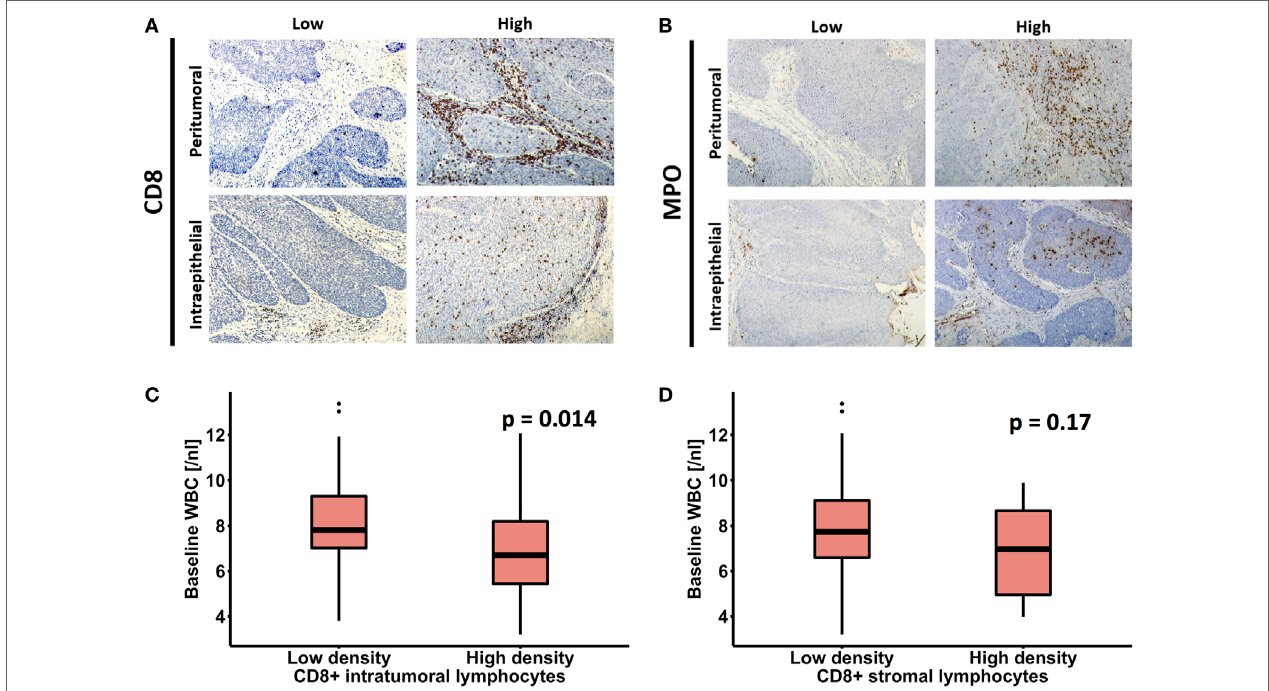
FigUre 2 | (a,b) Example of immunohistochemical images showing high and low CD8 and myeloperoxidase (MPO) expression in pretreatment biopsies of patients with anal squamous cell carcinoma. Association of peripheral white blood cell (WBC) count with (c) intratumoral and (D) peritumoral (stromal) CD8 +